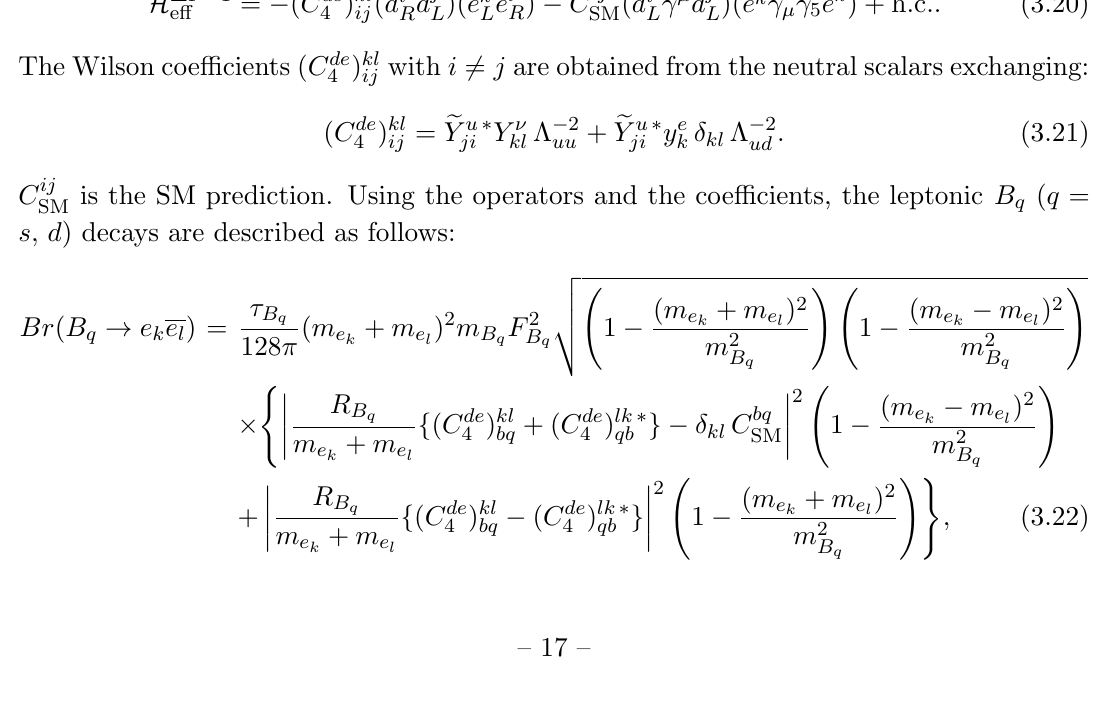
Figure 2 . Predictions of (cid:22) ! 3 e . The thick and dashed blue lines depict our predictions in the NO cases with ( Y (cid:23) ; Y (cid:23) ; M (cid:0) 1 )= (1 ; 0 : 1 ; 0) on the left panel and ( Y (cid:23) 11 33 (cid:23) 1 on the right panel. The thick and dashed red line describes our predictions in the IO cases with ( Y (cid:23) ; Y (cid:23) ; M (cid:0) 1 ) = (1 ; 0 : 02 ; 0) on the left panel and ( Y (cid:23) 11 33 (cid:23) 1 panel, respectively. (cid:3) uu and (cid:3) ud are (cid:12)xed at ((cid:3) uu ; (cid:3) ud ) = (200 TeV ; 100 (1) TeV) on the thick (dashed) lines. The green region is excluded by the experiment [66] and the dashed green line is the future prospect